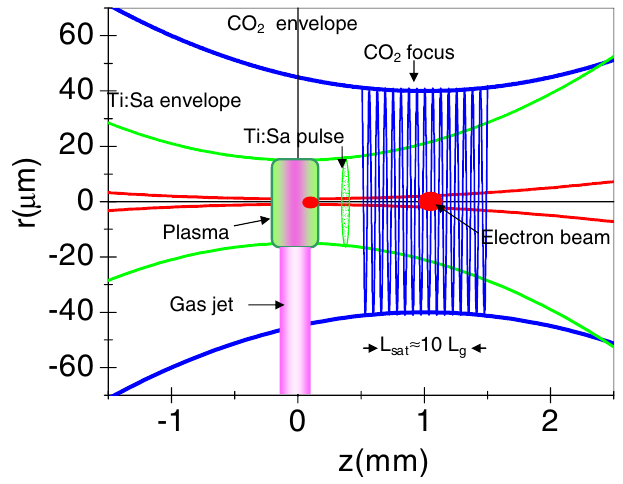
FIG. 1. (Color) Layout of the experiment for the case of the CO electromagnetic undulator for which the plasma density is over- critical (see text for